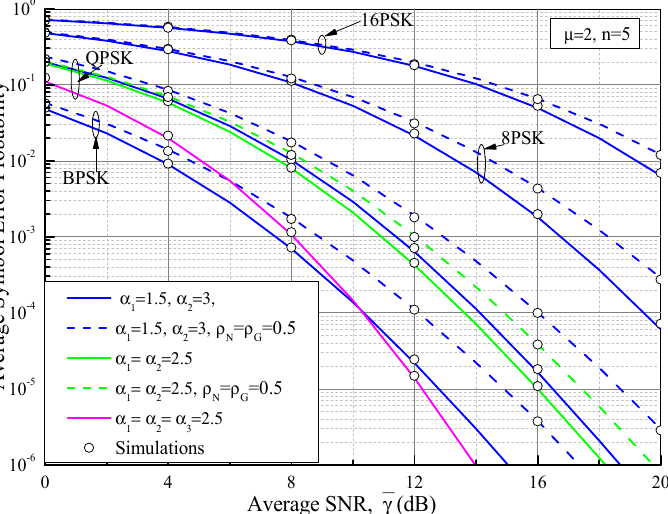
Figure 6. ASEP of MPSK for the MRC system as a function of the average SNR ( 𝛾̅ ) over i.n.i.d. and correlated α - μ /IGA fading channels with n = 5 and μ = 2.